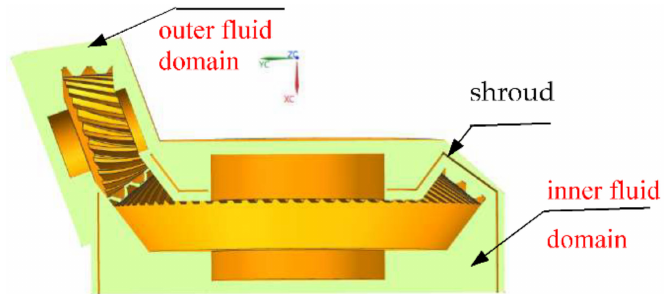
Figure 2. Computational flow domain model with shroud.